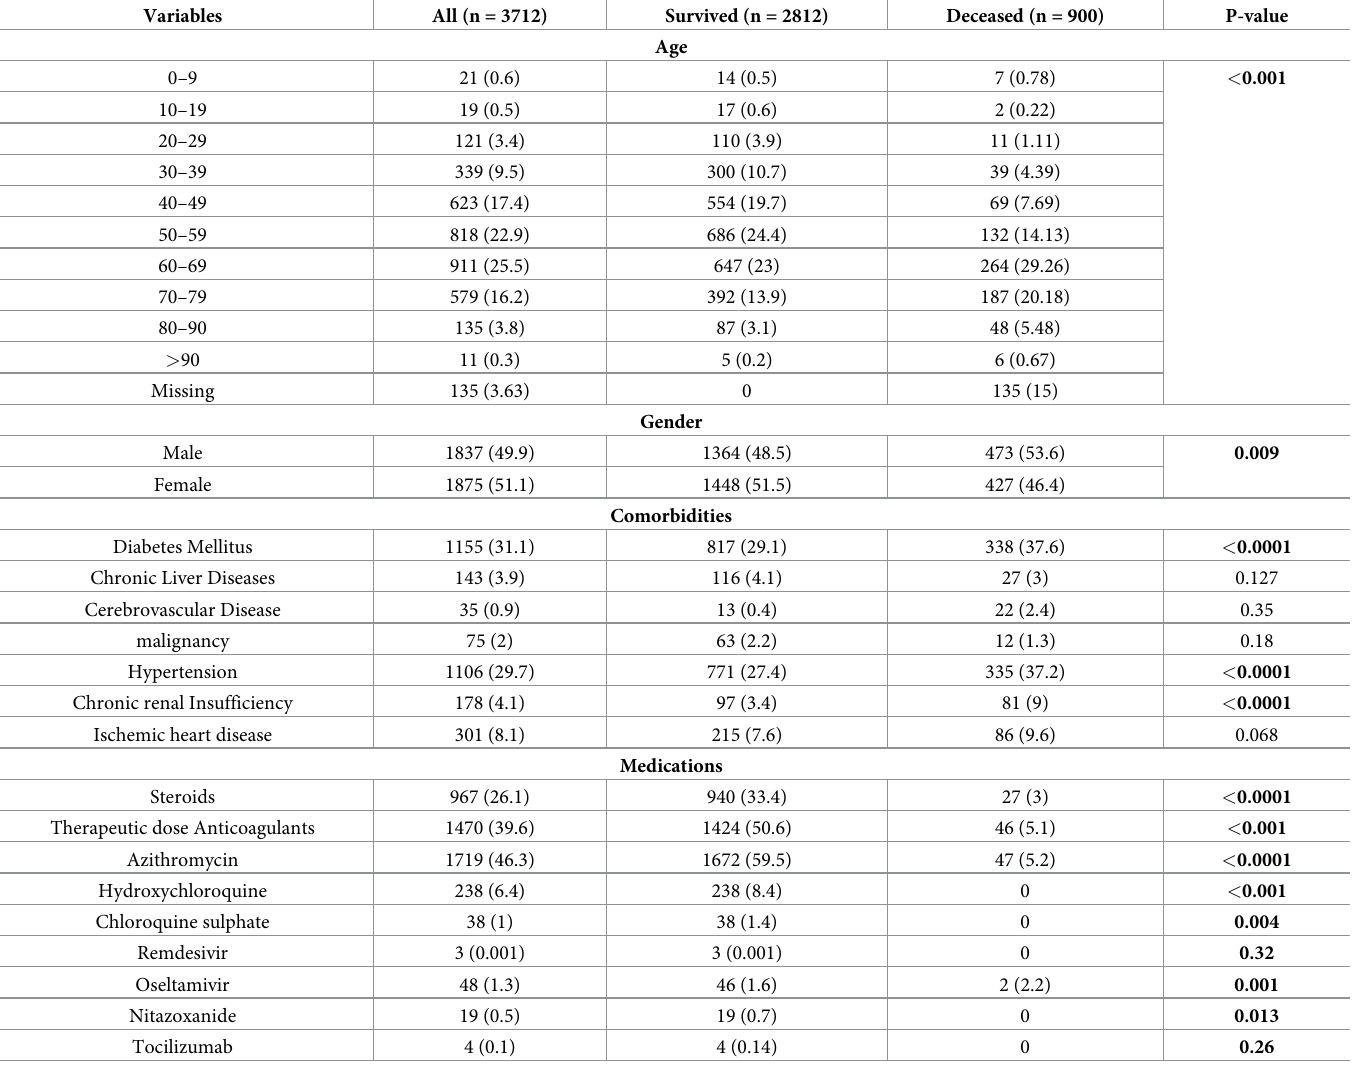
Table 1. Demographic characteristics and comorbidities (n =